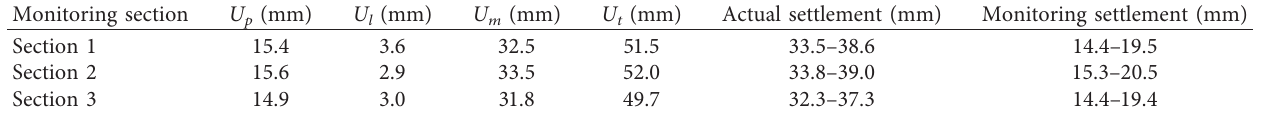
Table 7: Calculated displacement of each section during construction of the secondary